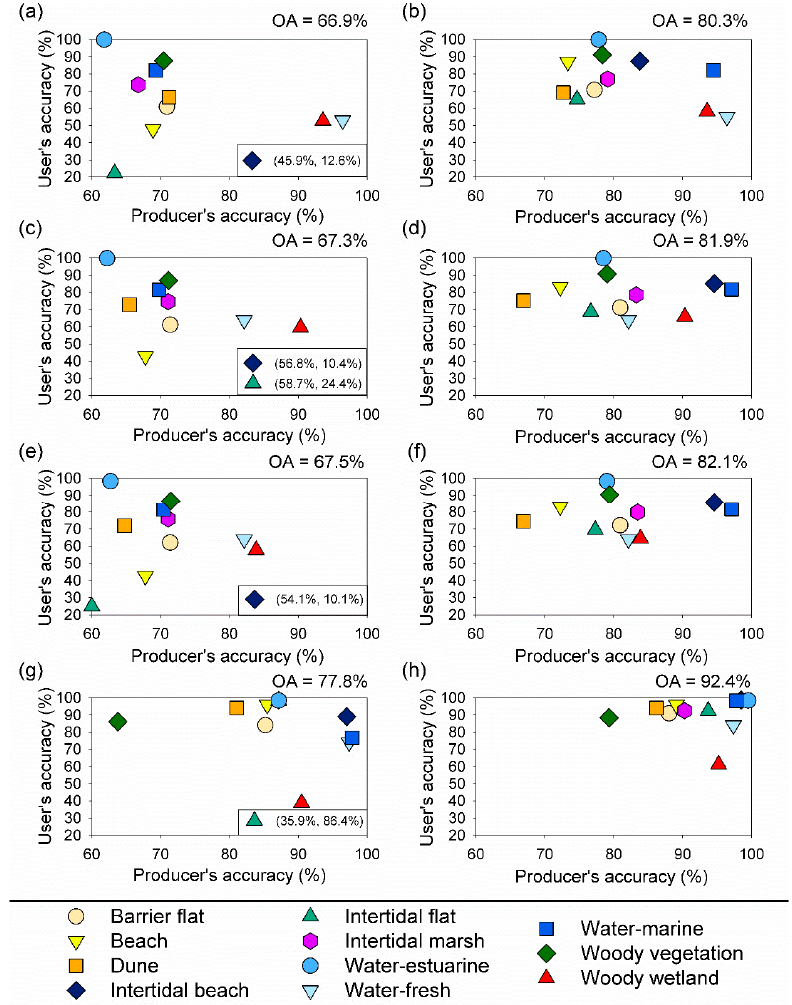
Figure 7. Producer’s and user’s accuracy results for the barrier island habitat model effort for Dauphin Island, Alabama, USA. ( a ) Class-specific deterministic accuracies for the final contemporary model without post-processing. ( b ) Class-specific fuzzy accuracies for the final contemporary model without post-processing. ( c ) Class-specific deterministic accuracies for the final contemporary model with post-processing, but no minimum mapping unit (MMU). ( d ) Class-specific fuzzy accuracies for the final contemporary model with post-processing, but no minimum mapping unit (MMU). ( e ) Class-specific deterministic accuracies for the final contemporary model with post-processing and a four-pixel MMU. ( f ) Class-specific fuzzy accuracies for the final contemporary model with post-processing and a four-pixel MMU. ( g ) Class-specific deterministic accuracies for the hindcast model with post-processing and a four-pixel MMU. ( h ) class-specific fuzzy accuracies for the hindcast model with post-processing and a four-pixel MMU. OA is the overall accuracy of the model results.